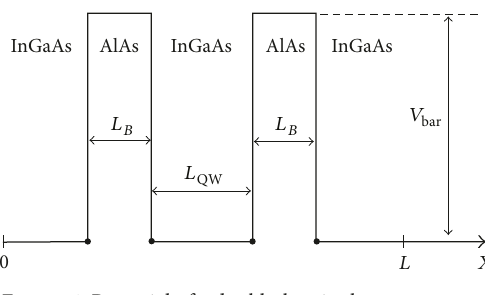
Figure 1: Potential of a double-barrier